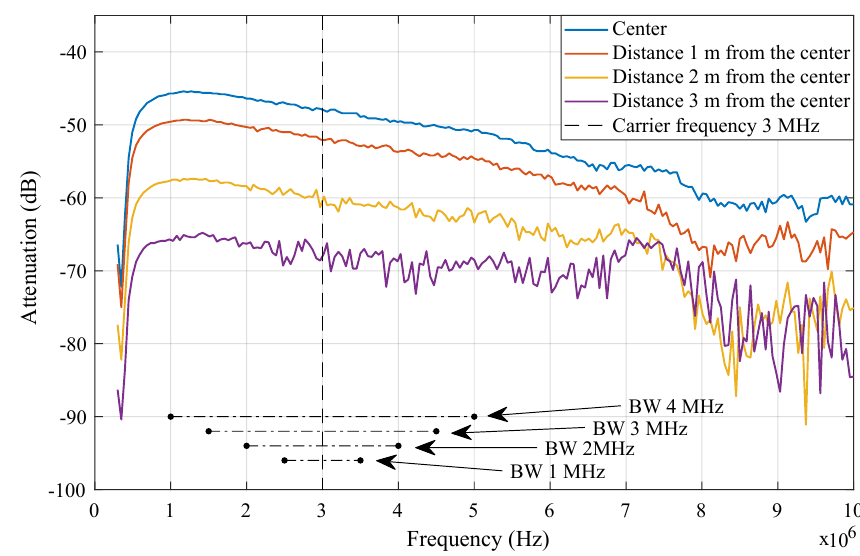
Figure 6. Attenuation characteristics of ceiling setup.